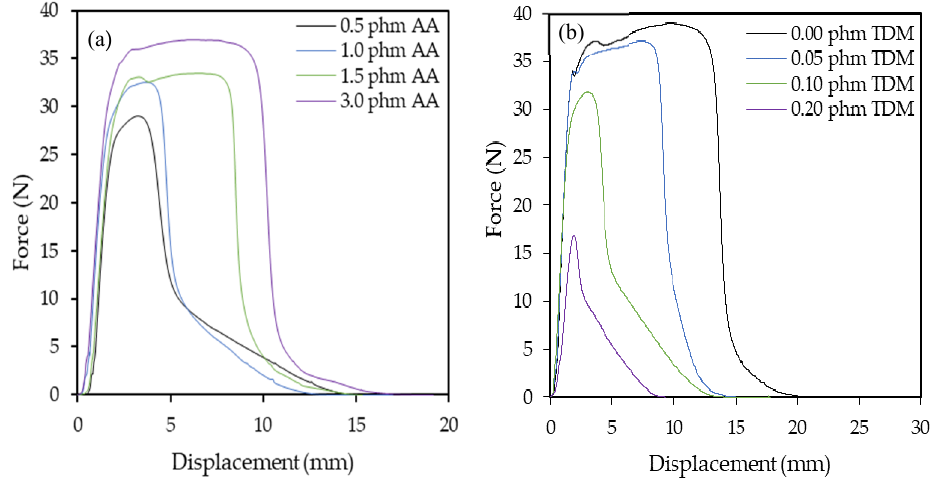
Figure 8. Experimental curves of dynamic shear test for ( a ) samples with constant tert-dodecyl mercaptan (TDM) ratio (0.05 phm) and ( b ) samples with acrylic acid (AA) ratio constant (3.0 phm).